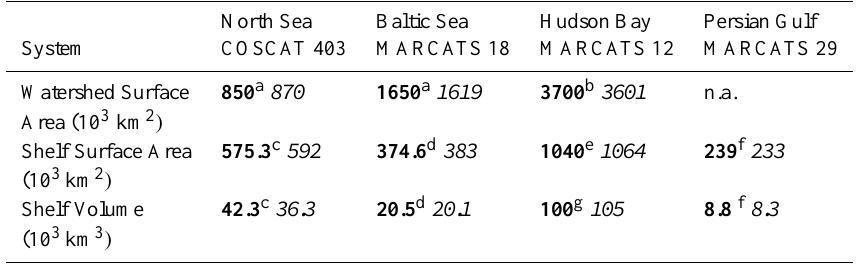
Table 4. Comparison between published (bold) and calculated (this study, italic) watershed surface area, water discharge, continental shelf surface and volumes in the North Sea, Baltic Sea, Hudson Bay and Persian